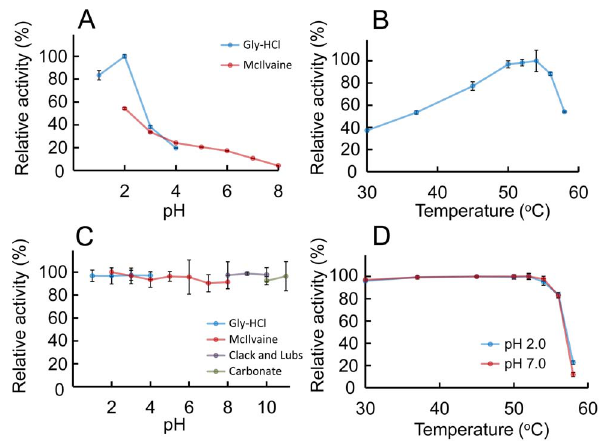
Figure 3. Characterization of the E. coli -expressed AMCase activities. (A) pH profile, (B) temperature profile, (C) pH stability profile and (D) thermostability profile of the chitinase for recombinant AMCase were measured as described in the Materials and Methods section. The values were represented as percentage of the maximum activity obtained in each series of experiments. Error bars represent the mean 6 standard deviation from a single experiment conducted in triplicate.